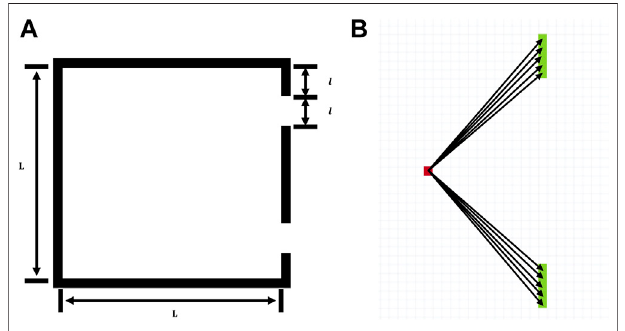
FIGURE1| Con fi gurationofevacuationarea (A) andDistanceevaluation of evacuation paths (from top to bottom are labelled sequentially from 1 to 10) (B)